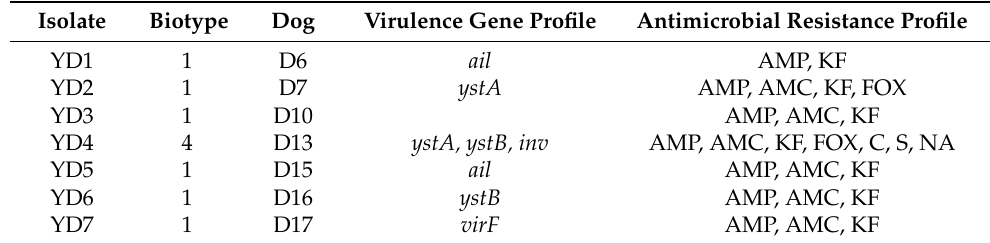
Biotype Virulence Gene